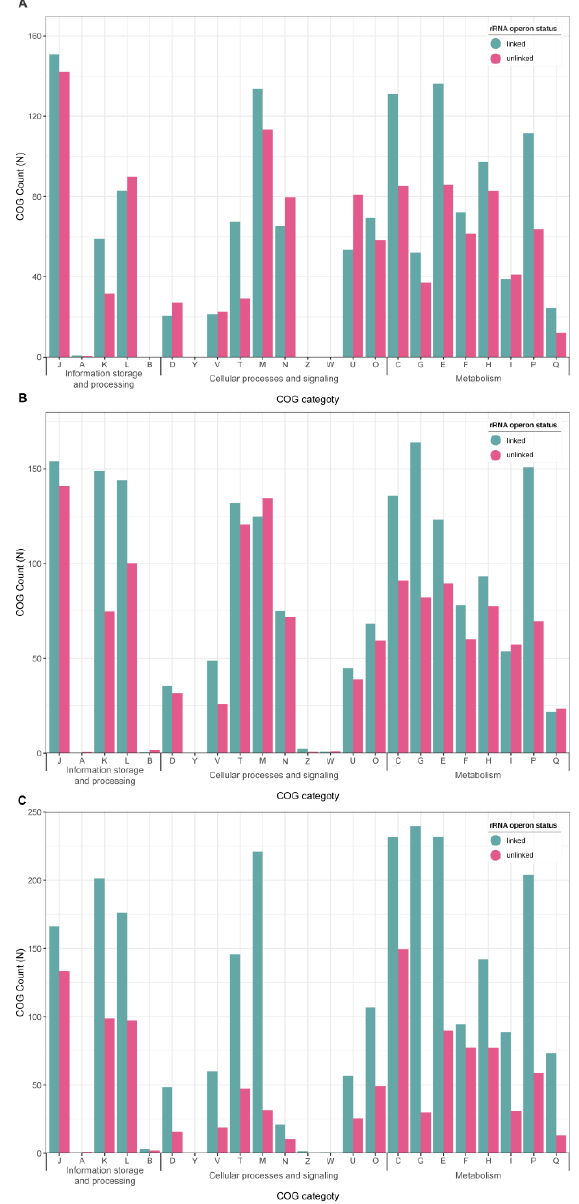
Figure 7. Quantitative abundance of Clusters of Orthologous (COG) categories between linked and unlinked genomes. Mixed genomes are excluded, and the average number of each group is shown. ( A ) Campylobacterota; ( B ) Spirochaetota; ( C ) Chloroflexota. COG functional categories: J, Translation, ribosomal structure, and biogenesis; A, RNA processing and modification; K, Transcription; L, Replication, recombination, and repair; B, Chromatin structure and dynamics; D, Cell cycle control, cell division, chromosome partitioning; Y, Nuclear structure; V, Defense mechanisms; T, Signal transduction mechanism; M, Cell wall/membrane/envelop biogenesis; N, Cell motility; Z, Cytoskeleton; W, Extracellular structures; U, Intracellular trafficking, secretion, and vesicular transport; O, Post-translational modification, protein turnover, chaperones; C, Energy production and conversion; G, Carbohydrate transport and metabolism; E, Amino acid transport and metabolism; F, Nucleotide transport and metabolism; H, Coenzyme transport and metabolism; I, Lipid transport and